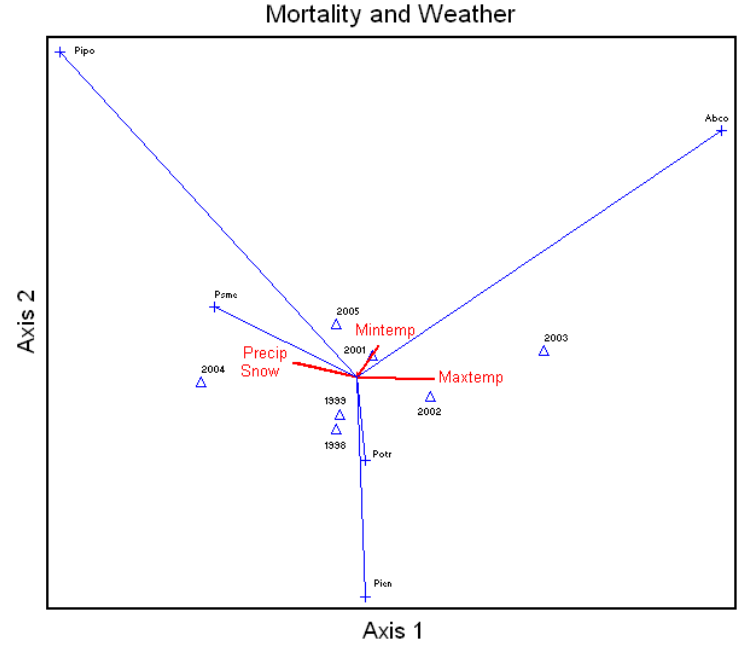
Figure 4. Canonical Correspondence Analysis Ordination on average percent mortality of all